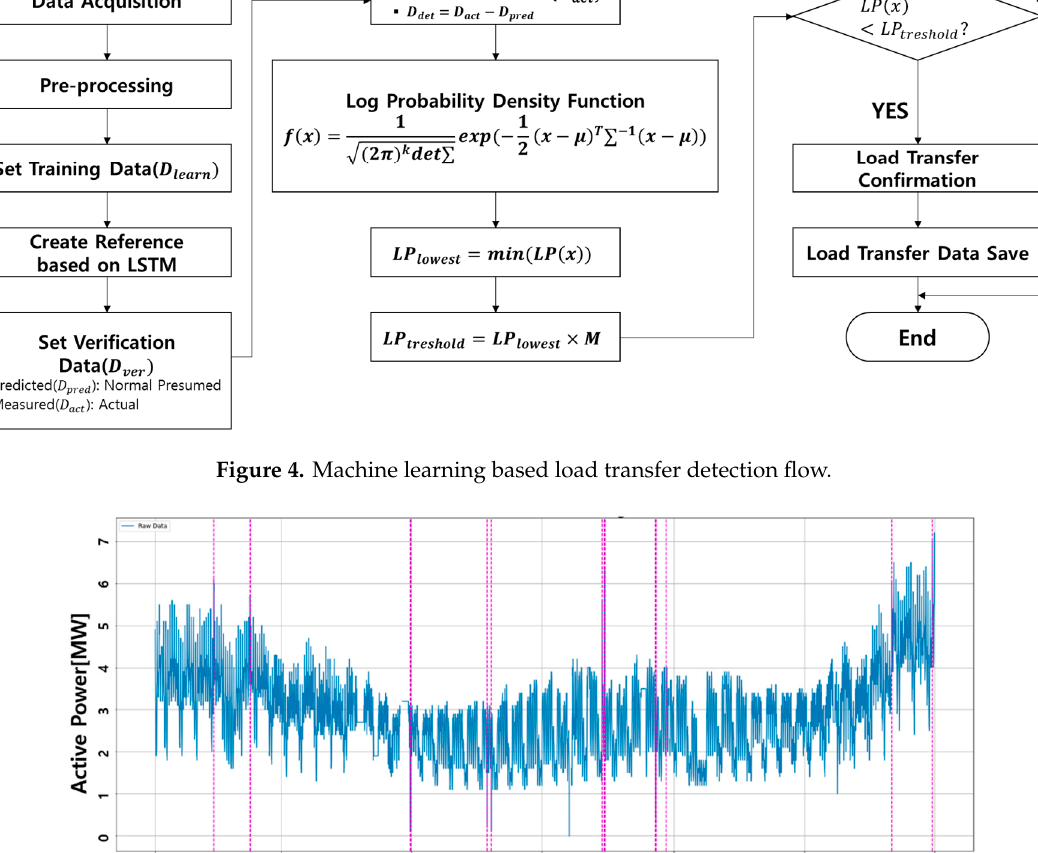
Figure 5. Machine learning based load transfer detection result (Kimhwa D/L).